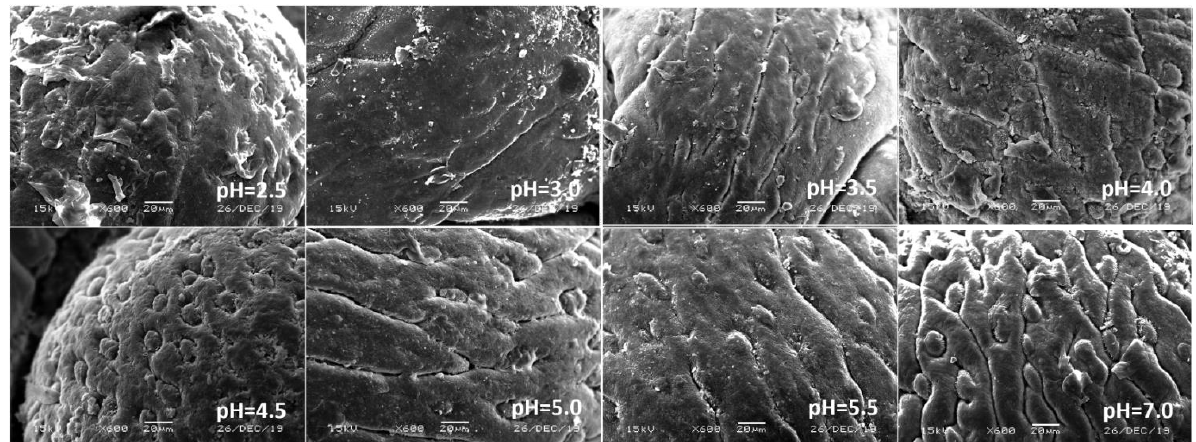
Figure 7. Epidermis of the first segment of adult Eisenia fetida in soil under acid rain with eight pH levels for 15 days ( n = 10). Treatments: pH 7.0: control, pH 2.0–5.5: acid rain with different pH levels.